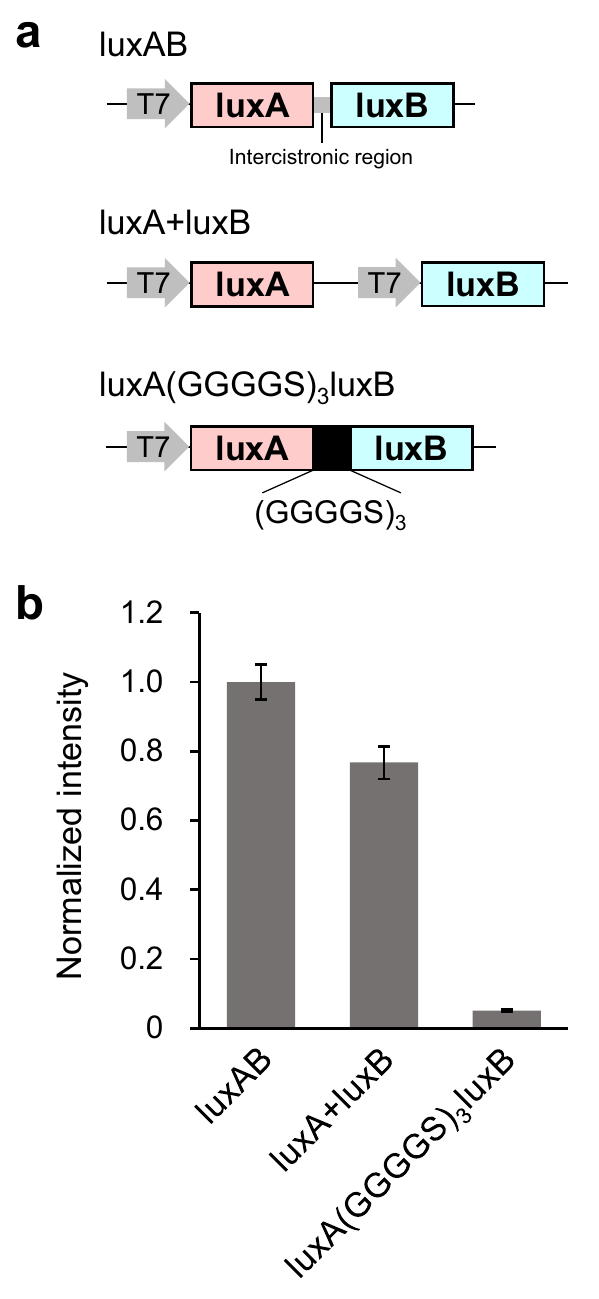
Figure 1. Comparison of the expression constructs of luxA and luxB genes in E. coli . ( a ) Schematic representation of expression constructs of luxA and luxB genes in pRSET B vector. ( b ) Luminescence intensities in the whole cell suspensions of JM109(DE3) expressing the recombinant proteins from each construct. The luminescence reaction was initiated by the addition of 1% decanal. Data are means ± SD of three different